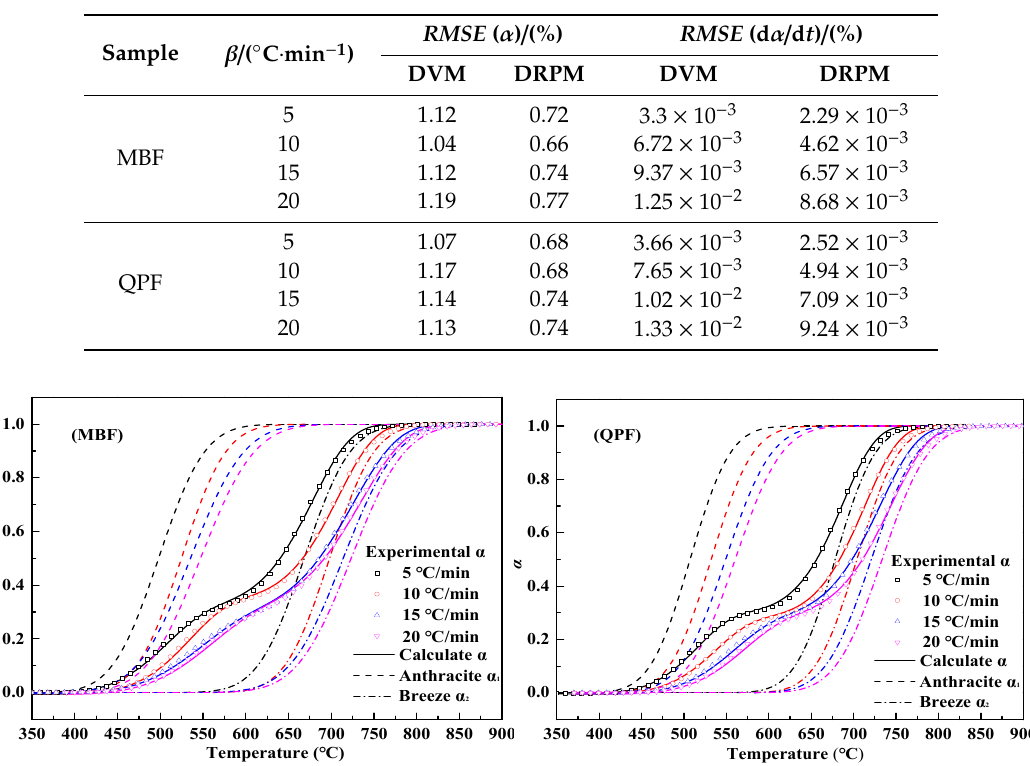
Table 7. Deviation between the experimental and calculated curves.